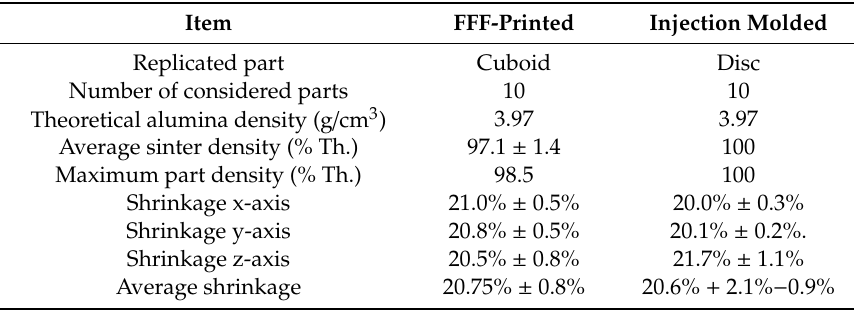
Table 5. Comparison FFF-printed parts with injection molded